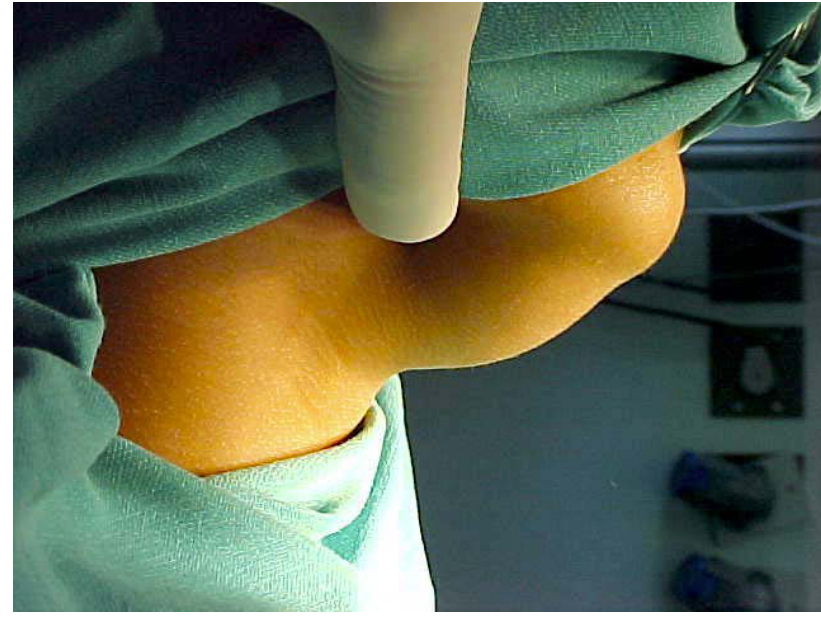
FIGURE 1 . Preoperative view of the submental area showing a compressible mass in a 12-year-old child.